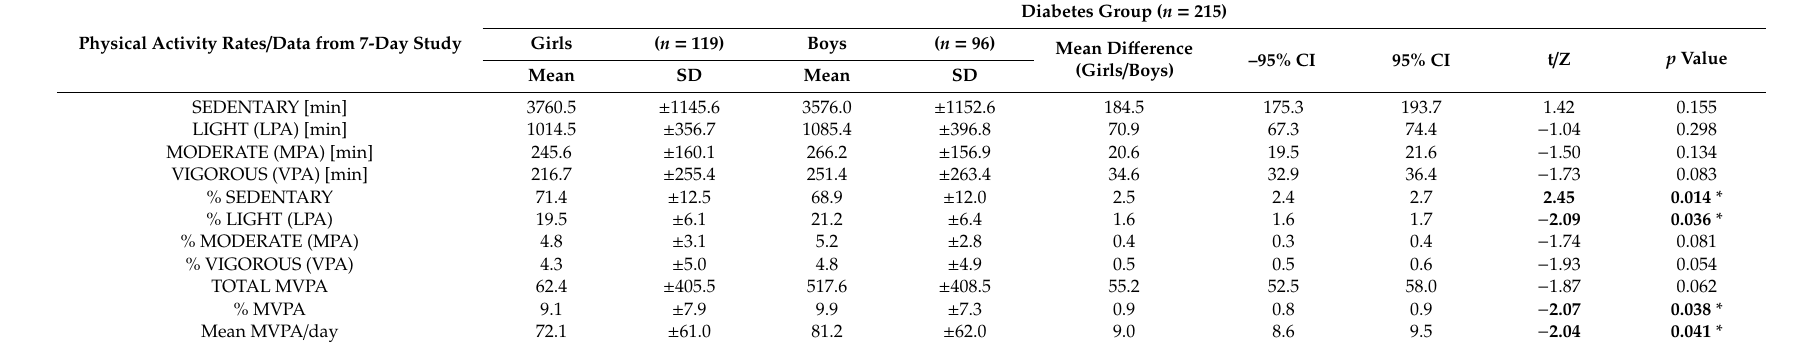
Table 5. Physical activity rates in the diabetes and the control groups depending on